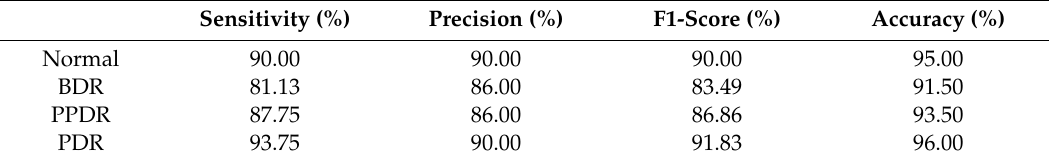
Table 2. Sensitivity, precision, F1-score, and accuracy for 200 test